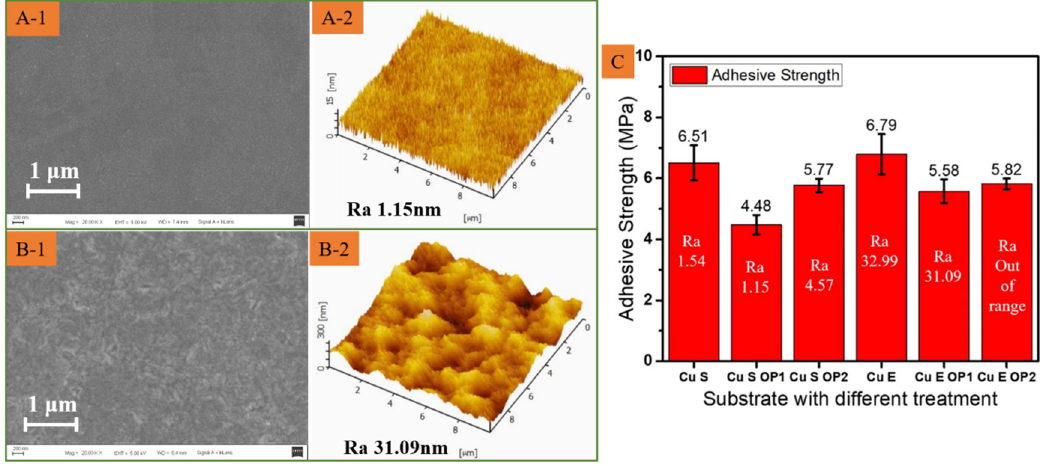
Figure 5. SEM and AFM of sputtered Cu ( A-1 , A-2 ); electroplated Cu ( B-1 , B-2 ) with oxygen ion bombardment. ( C ) adhesion strength test results.